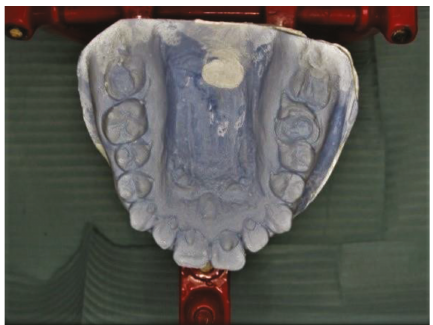
Figure 11: Case 3: talon cusps in all upper anterior teeth (study